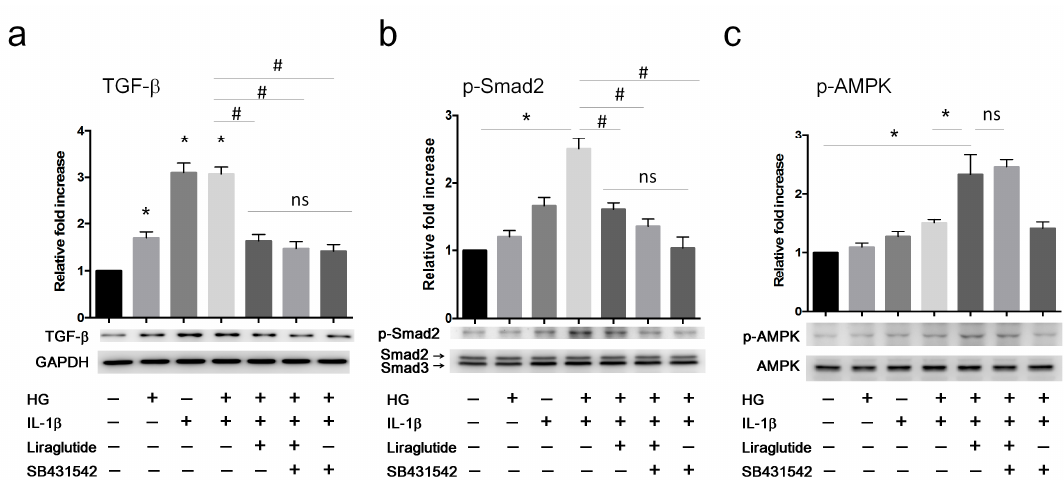
Figure 5. Liraglutide attenuates high glucose- and IL-1 β -induced TGF- β signaling in HUVECs. HUVECs were cultured in the conditions indicated for 24 h. Cells were harvested for western blot analyses of the protein levels of ( a ) TGF- β and Glyceraldehyde 3-phosphate dehydrogenase (GAPDH) as an internal control, ( b ) p-Smad2 and total Smad2/3 as an internal control, and ( c ) p-AMPK and total AMPK as an internal control. Quantification of the relative fold increase is shown as the mean ± SD from three independent experiments. * P < 0.05 compared to saline control. # P < 0.05 compared to HG+IL-1 β group. The statistical significance was assessed by Kruskal–Wallis test. To further confirm whether liraglutide inhibits EndMT via the AMPK pathway, we treated the HUVECs with liraglutide (1 μ g/mL) or with the AMPK inhibitor Compound C (1 μ M) followed by exposure to HG+IL-1 β for 72 h. Liraglutide enhanced p-AMPK and reduced p-Smad2 in HG+IL-1 β -treated HUVECs (Figure 6a). The inhibition of AMPK by Compound C attenuated the liraglutide-mediated effects on signal transduction (p-AMPK and p-Smad2) and EndMT marker expression (CD31, SM22 α , Snail, and vimentin) (Figure 6b,c). Taken together, these results indicate that liraglutide reverses HG+IL-1 β -induced EndMT via the AMPK pathway.